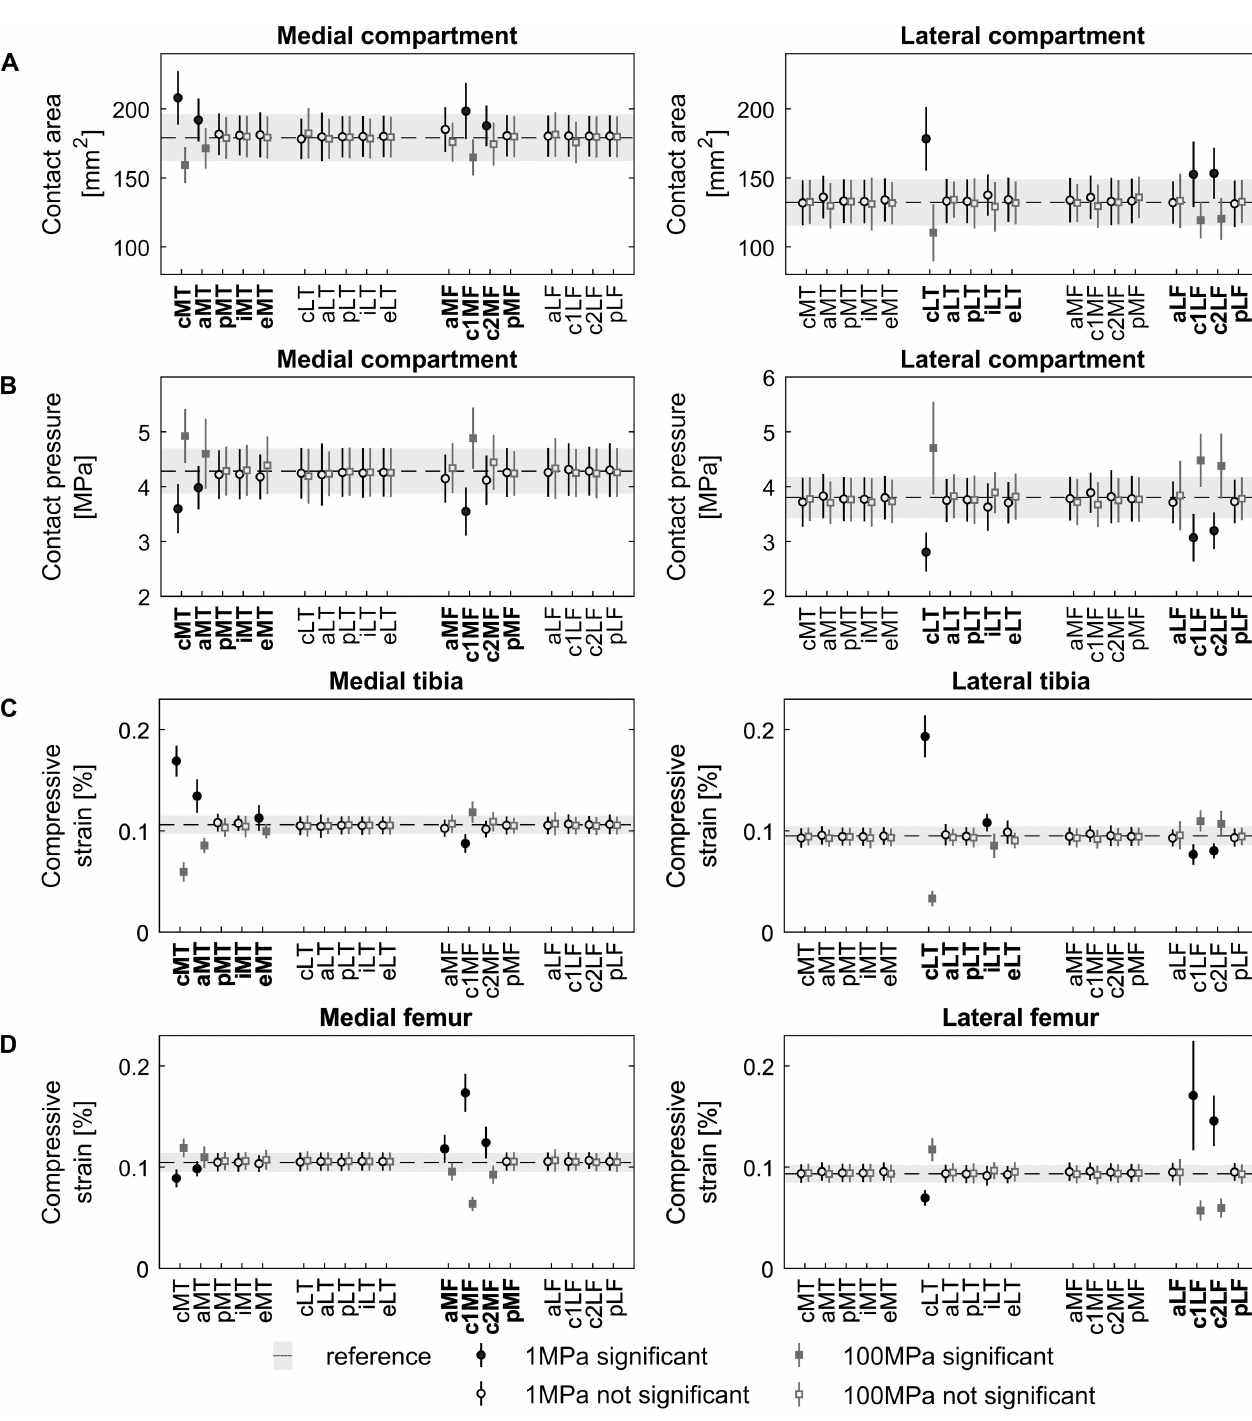
PLOS ONE | https://doi.org/10.1371/journal.pone.0205842 October 16,